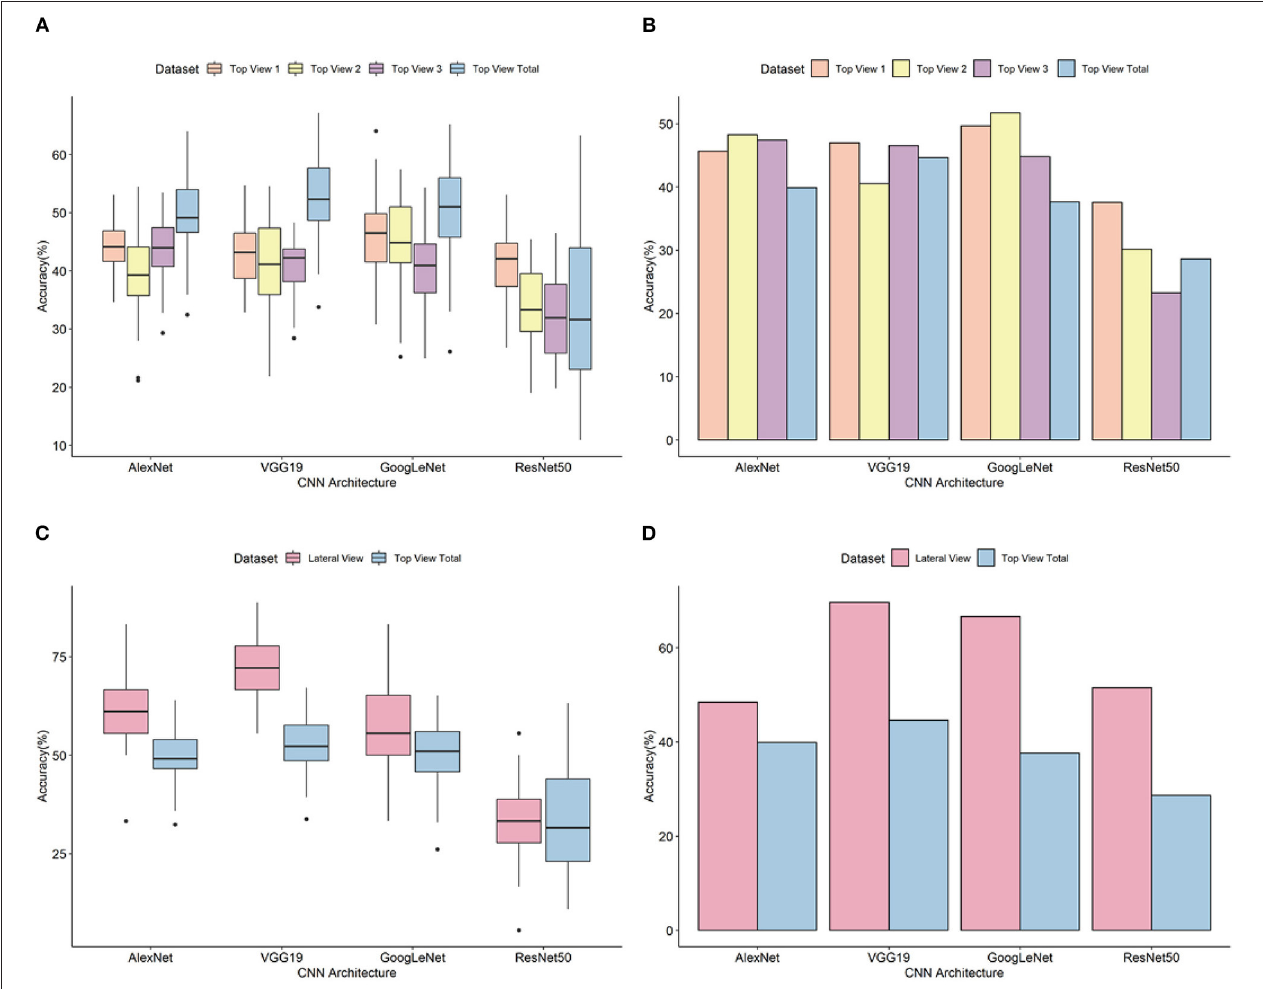
FIGURE 4 | Validation and evaluation of the classification models. (A) Prediction accuracy of top view datasets based on 50 iterative validations. (B) Prediction accuracy using the test set of top view datasets. (C) Prediction accuracy of top and lateral view datasets based on 50 iterative validations. (D) Prediction accuracy using the test set of top and lateral view datasets. The horizontal axis indicates the analytical architectures, and the vertical axis indicates the prediction accuracy (%). Orange, yellow, purple, light blue, and pink colors stand for types of image